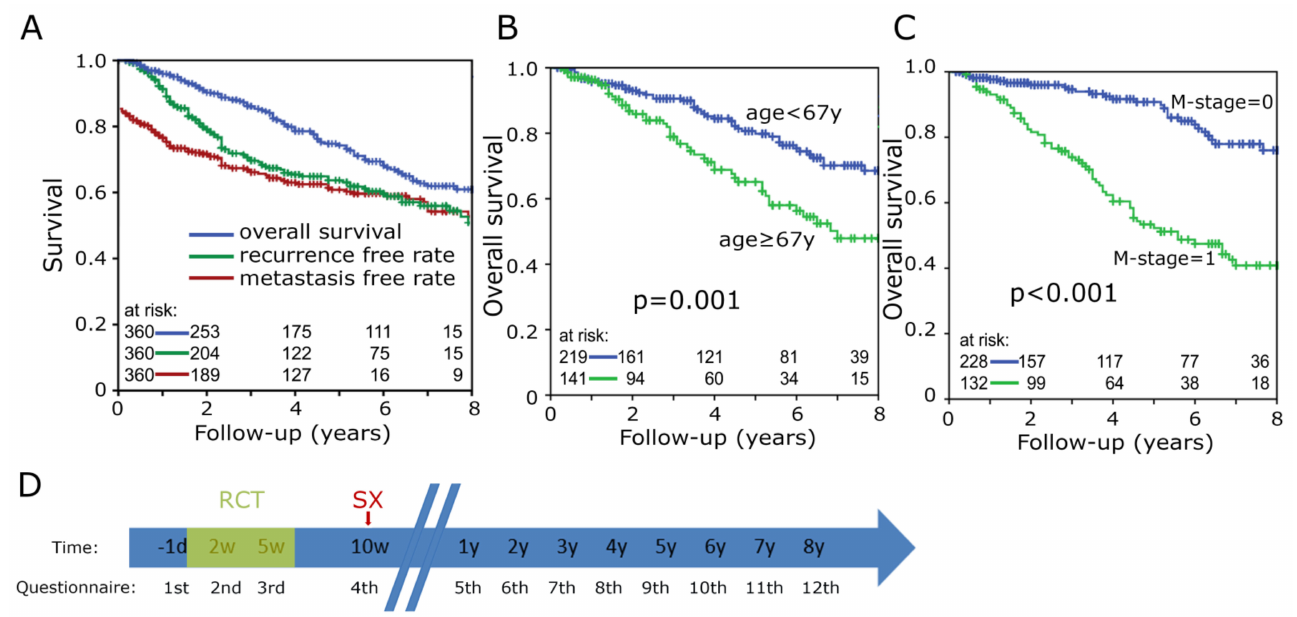
Figure 1. Kaplan-Meier plots for ( A ) Overall survival (upper blue line), recurrence-free rate (middle green line) and metastasis-free rate (bottom red line) of the entire cohort; ( B ) Cohort divided by age into below 67 years (upper blue line) and 67 years and above (bottom green line); ( C ) Metastasis status M = 0 (upper blue line) and M = 1 (bottom green line). ( D ) Timeline of each date when patients received questionnaire. Referring to the first day of radiochemotherapy (RCT), (SX) highlights day of